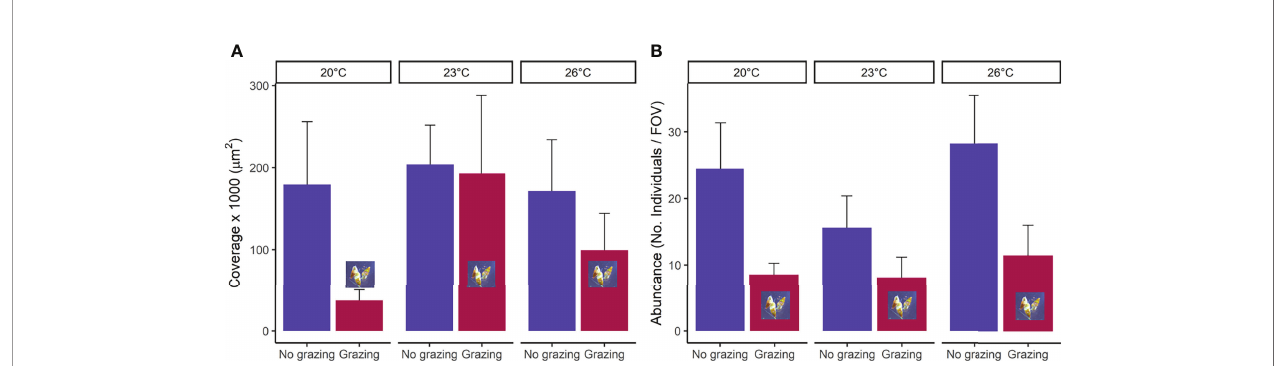
FIGURE 1 | (A) mean total coverage per fi eld of view (FOV=3.2mm 2 ) and (B) abundance (No. of individuals per FOV) of Ecklonia radiata gametophytes in the presence (grazed) and absence (non-grazed) of Anachis atkinsoni at three temperatures (20°C, 23°C, 26°C) directly after removal of the grazer (48H). Error bars represent SE, n